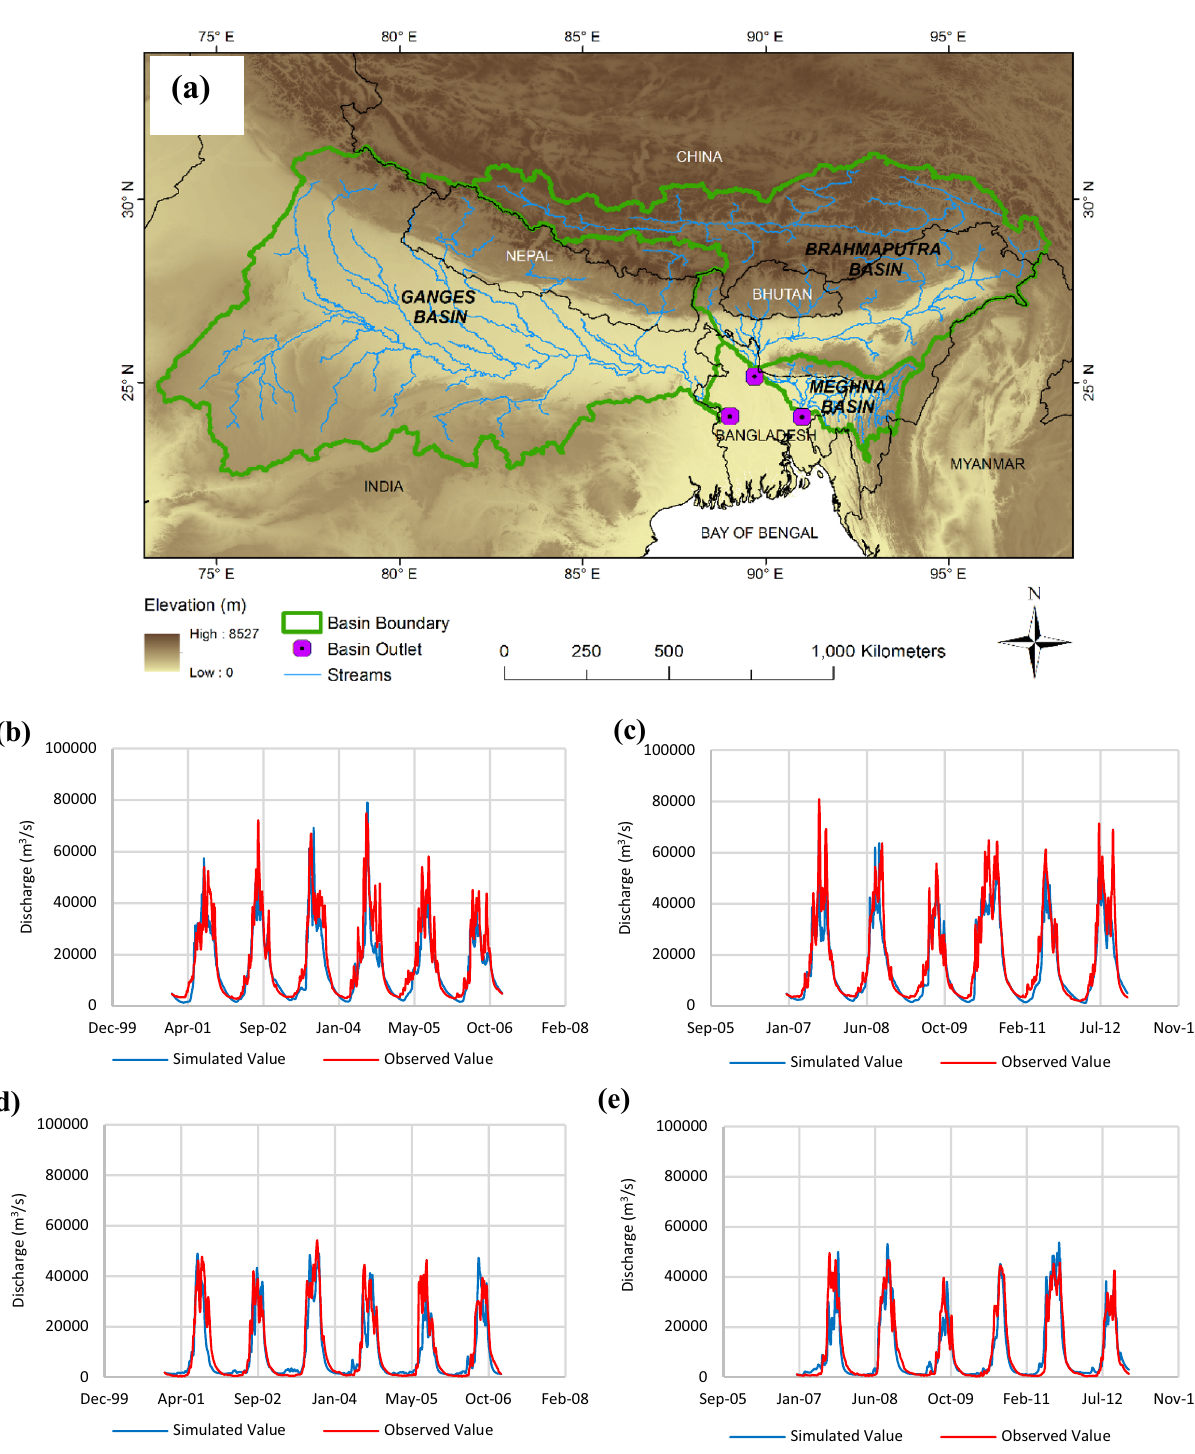
Fig. 3 a SWAT model developed for GBM basins; b Calibration and c Validation of Brahmaputra; d Calibration and e Validation of Ganges basin ( Source: Mohammed et al.